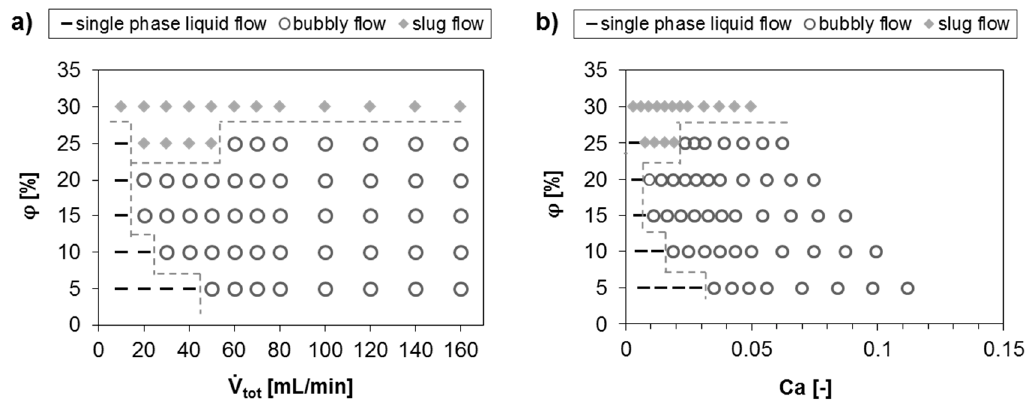
Figure 7. Flow maps for varying total volumetric flow rates and void fraction. ( a ) Void fraction plotted over total volumetric flow rate with observed flow regimes; ( b ) void fraction plotted over capillary number Ca with observed flow regimes. Legends are included in the diagram.